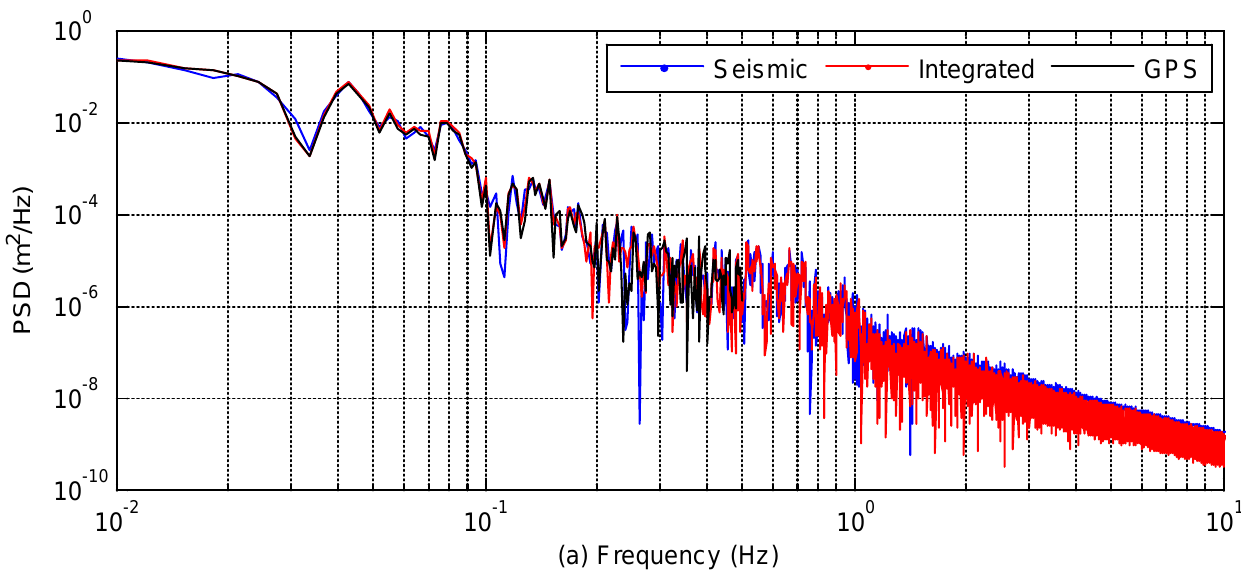
Figure 4. Power spectral densities. ( a ) Power spectral density for 1 Hz GPS displacements at station 0183 (the black line), 100 Hz seismic displacements at AKT006 (the blue), and 100 Hz tightly-integrated displacement waveforms at AKT006/0183 (the red line). ( b ) Power spectral density for 5 Hz GPS displacements at P744 (the black line), 200 Hz seismic displacements at 5028 (the blue line), and 200 Hz tightly-integrated displacements at P744/5028 (the red